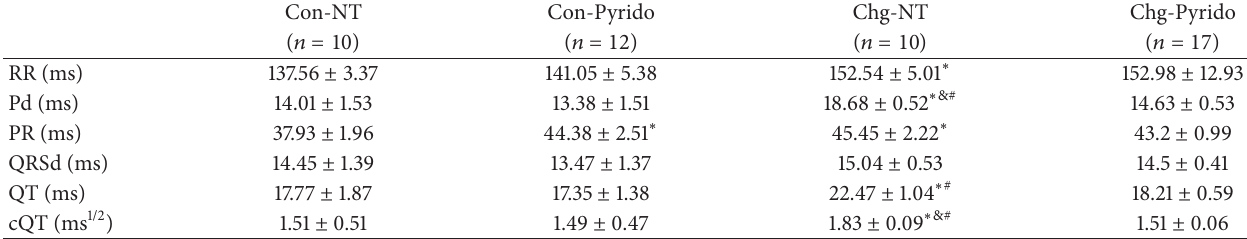
Table 2: Electrocardiogram after treatment with pyridostigmine bromide. Electrocardiographical parameters (expressed as mean ± S.E.M.) collected at the 6th month of observation and after one month of treatment (from the 5th to 6th month of infection) in noninoculated control (Con) or T. cruzi- inoculated (Chg) anesthetized C57BL/6j mice treated with pyridostigmine bromide (Pyrido) or vehicle (NT: nontreated animals). Con-NT